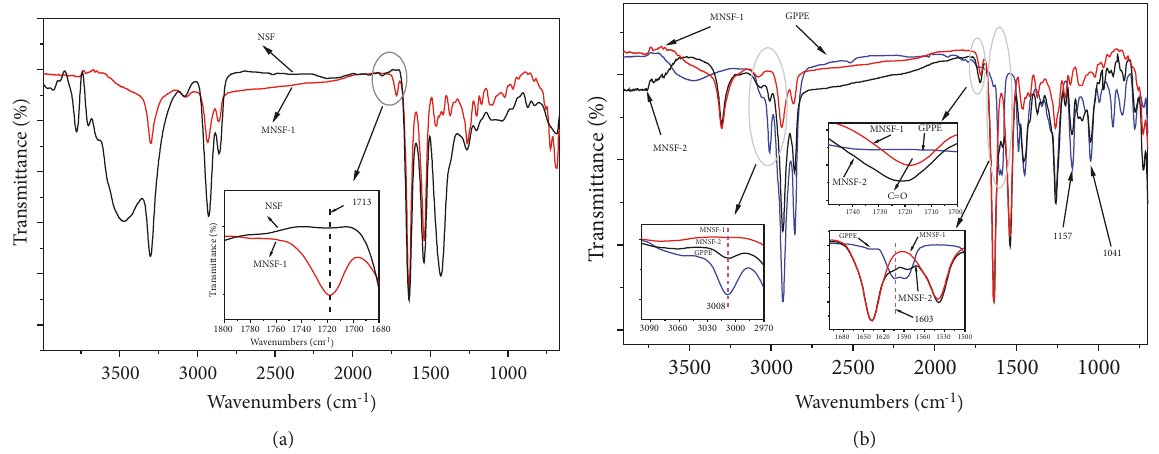
Figure 2: FT-IR spectra of GPPE and short fibers with and without